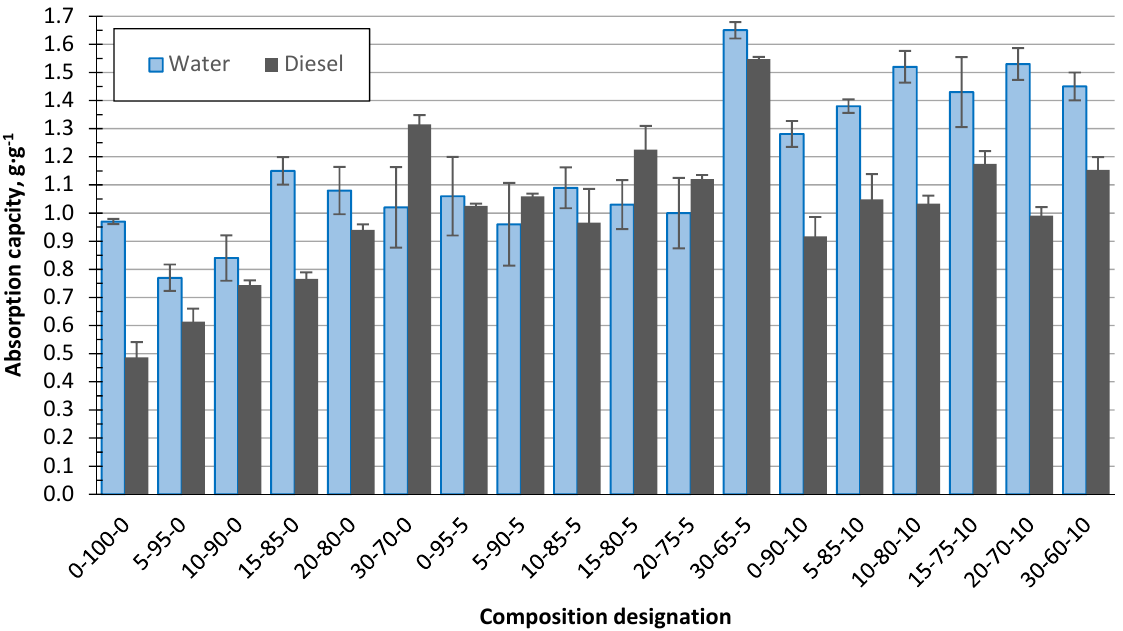
Figure 12. Sorbent water and diesel uptake capacity in g/g for granules compositions.